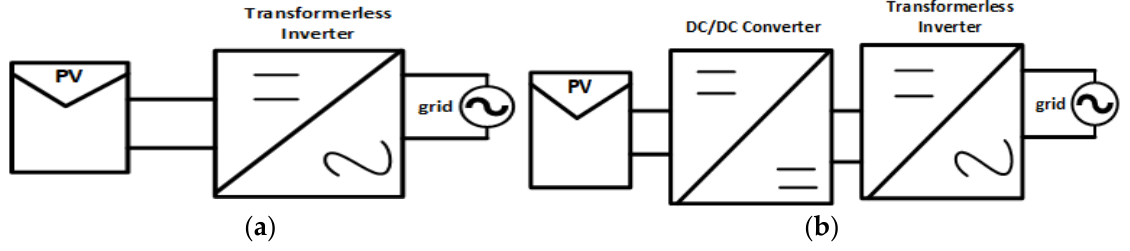
Figure 1. Structure of transformerless inverter: ( a ) single stage; ( b ) two-stage.